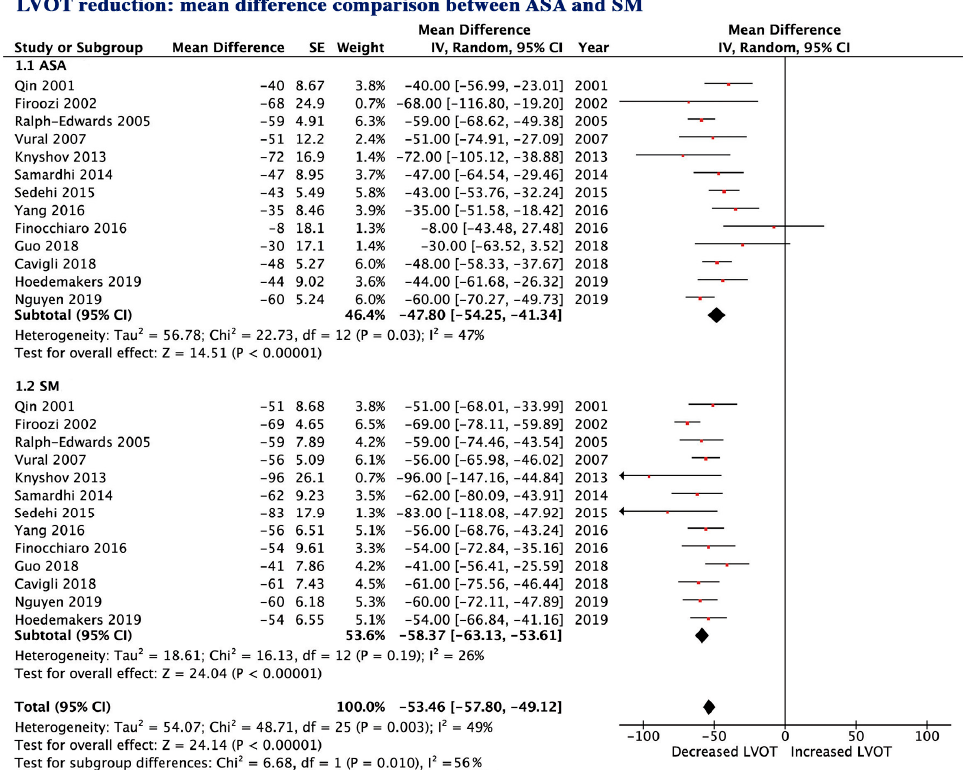
Figure 4. Summary of clinical outcome in two groups of treatment. ASA, alcohol septal ablation; SM, surgical myectomy; CI, confidence interval, CV, cardiovascular, SCD, sudden cardiac death, RR, relative risk, NYHA, New York Heart Association.